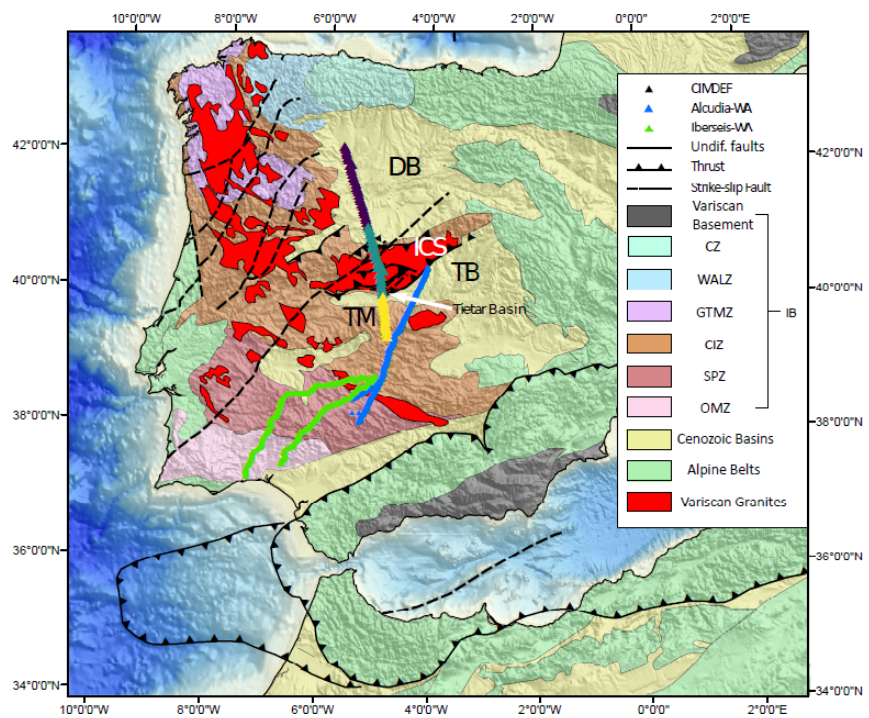
Figure 1. Simplified geological map of the study area with major tectonic provinces and structures of the Iberian Massif (modified after Andrés et al., 2019). Location of the main seismic profiles acquired in the area is also shown. Colour-coded by deployment: green (first deployment), yellow (second deployment), and purple (third deployment). TM: Toledo mountains; ICS: Iberian Central System; DB: Duero Basin; TB: Tajo Basin; CZ: Cantabrian Zone; WALZ: West Asturian Leonese Zone; GTMZ: Galicia–Trás-os-Montes Zone; CIZ: Central Iberian Zone; OMZ: Ossa-Morena Zone; SPZ: South Portuguese Zone. Locations of Variscan granites and granitic zonation are taken from Simancas et al. (2013).